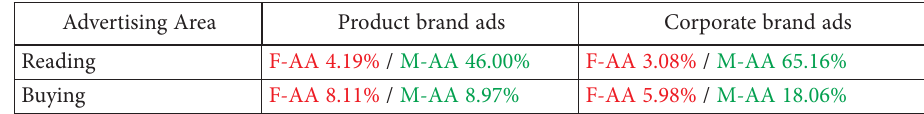
Table 1. Advertising Area (AA) average Fixation count (F) and short-term Memory (M) averages for all four